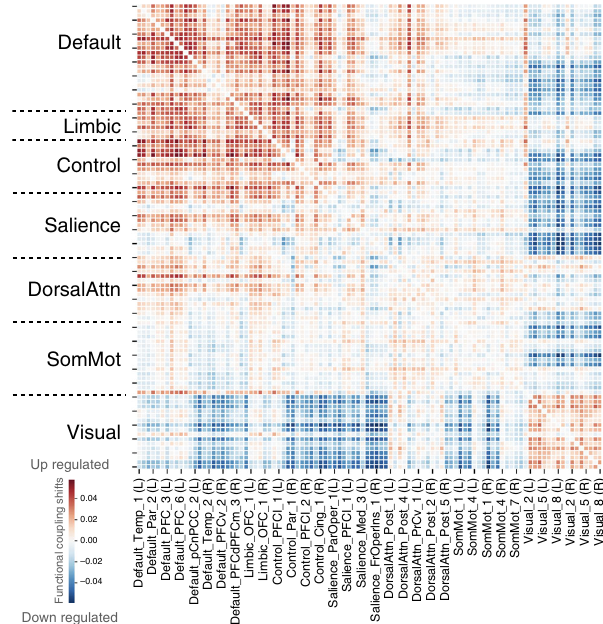
Fig. 2 Statistically strongest population mode of functional connectivity deviations related to loneliness. Loneliness is linked to functional coupling shifts (on z -score scale) with increased intra-network connectivity especially in the default network and decreased inter-network connectivity of the visual cortex with various other neural systems, including the default network. The best partial least-squares mode was computed and